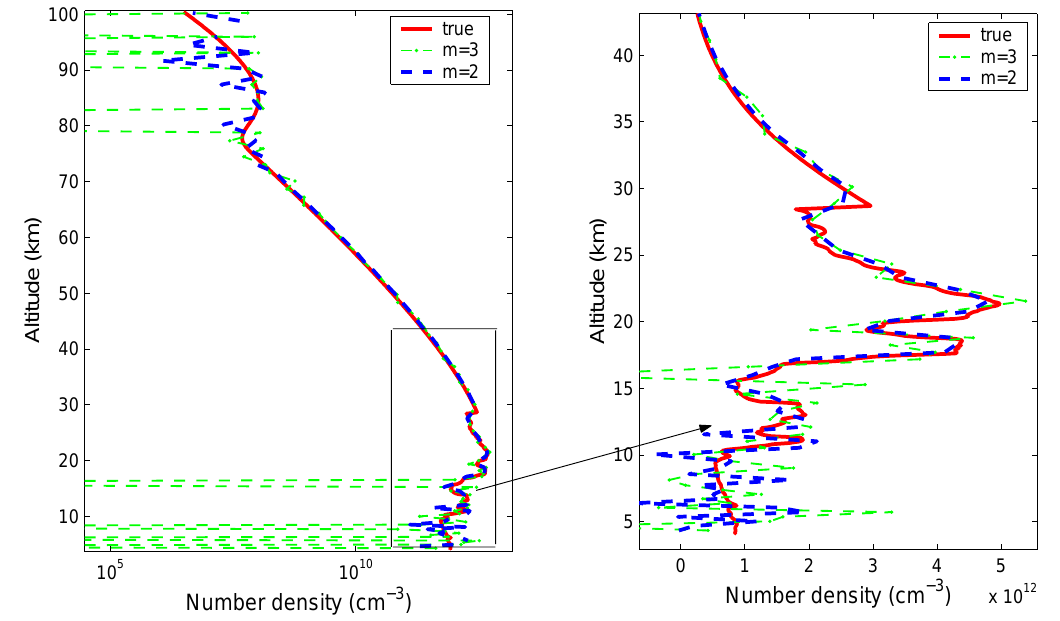
Fig. 3. Pre-launch simulation of the ozone profile retrievals for stars of magnitude m = 2 and m = 3. Right panel is zoom.